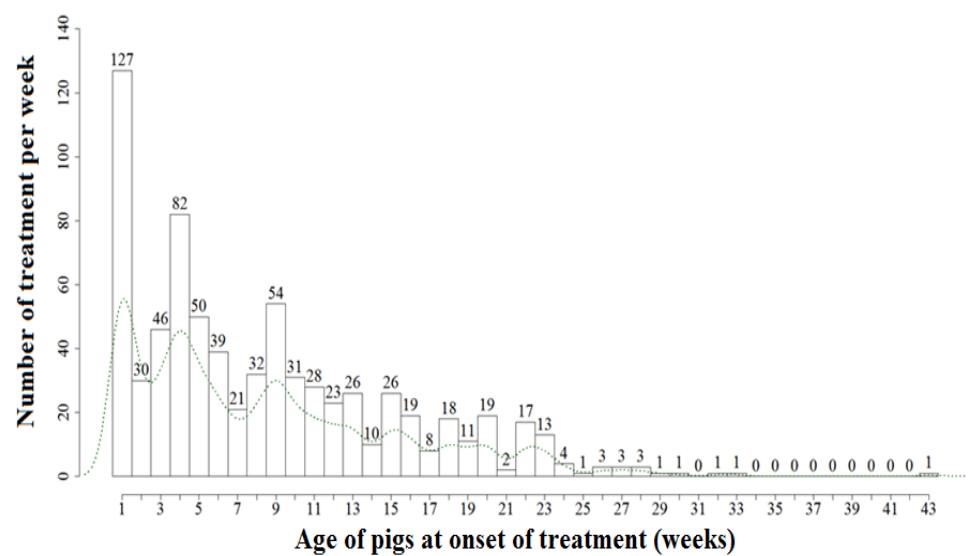
Figure 2. Histogram showing the number of antimicrobial group treatments per week applied to a batch of pigs from birth to slaughter based on 750 treatments (30 instances of treatments missing). The green dotted line represents the weekly average treatment incidence (adapted from Sarrazin et al., 2019) [48].